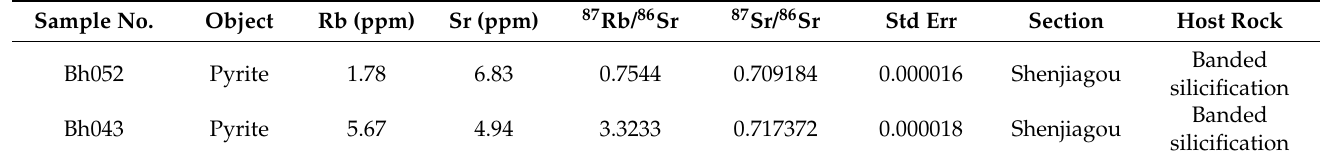
Figure 8. Rb–Sr isochrons of pyrite from banded silicification ( a ), diorite porphyrite ( b ), and quartz Table 5. Rb-Sr isotopic dating of pyrite samples from Liziyuan gold veins ( c ). Table 5. Rb-Sr isotopic dating of pyrite samples from Liziyuan gold deposit.